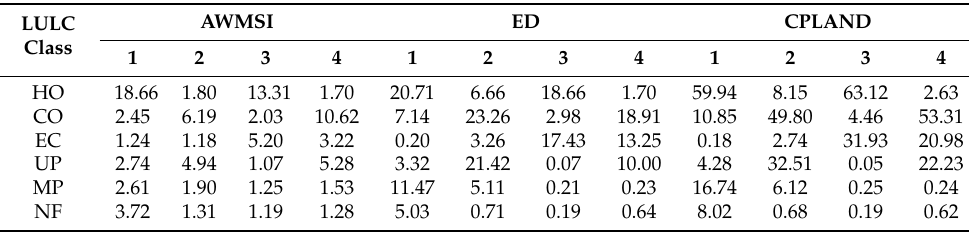
Table 9. Weighted mean shape index (AWMSI), edge density (ED) and core area percent of landscape (CPLAND) per